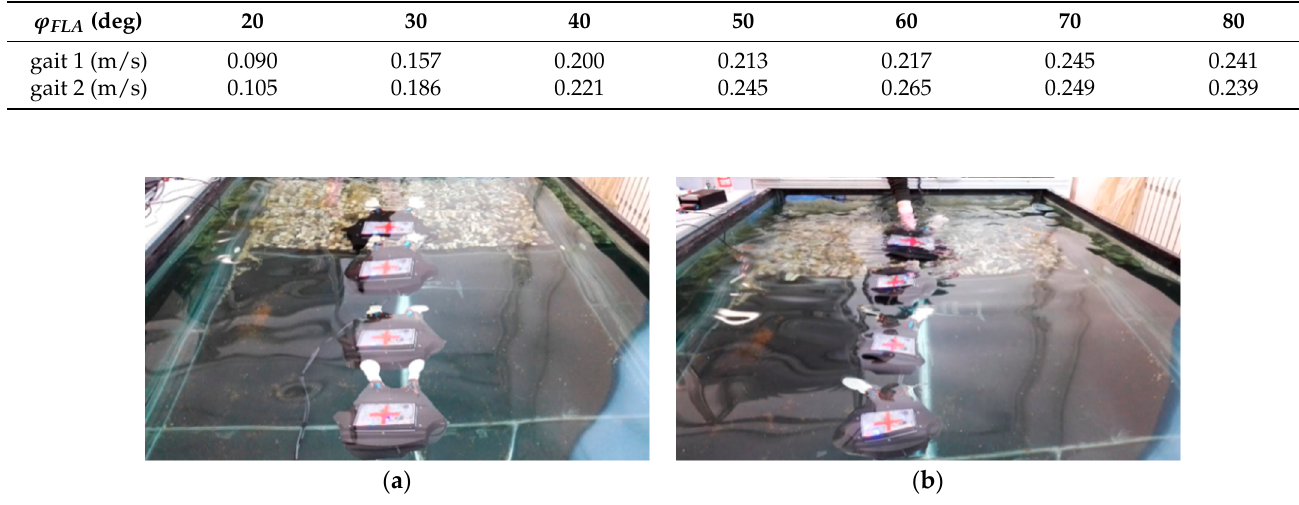
Figure 16. The comparison experiment in an indoor water tank. ( a ) is the scene of gait 1. ( b ) is the scene of gait 2. The videos of the comparison experiment are shown in the Supplementary Materials S4 and S5. Table 3. Comparison of swimming speed between two gaits. ( f = 1.0 Hz).